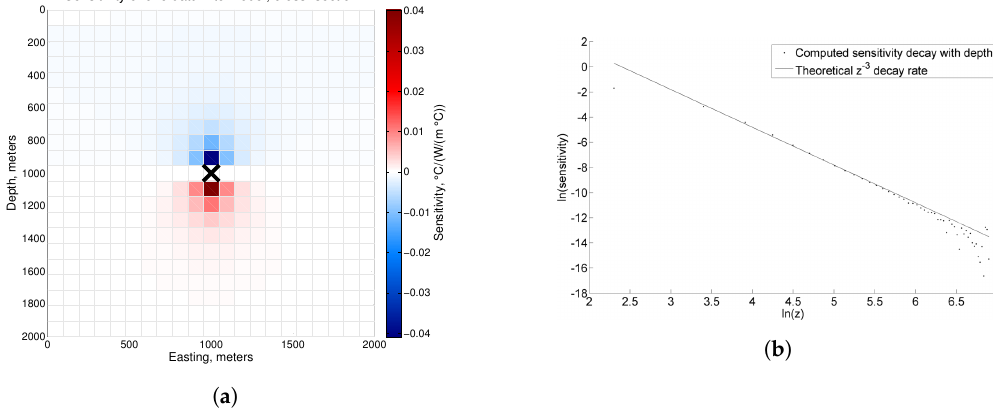
Figure 1. ( a ) Sensitivity of one borehole temperature datum to thermal conductivity for a homogeneous thermal conductivity model. The temperature datum is located in the center of the cell marked by the X. Temperature increases at that location if the thermal conductivity of red cells increases. Temperature decreases with an increase in the thermal conductivity of blue cells. The sensitivity decays with distance from the location of the temperature datum, especially laterally. ( b ) The decay of the sensitivity of surface heat flow to thermal conductivity as a function of the depth of the conductivity. The sensitivities were computed on a 50 by 50 by 50 regular grid for a homogeneous thermal conductivity model. A decay rate proportional to z − 3 is overlain on the plot. The fit serves to justify the use of the proposed depth weighting